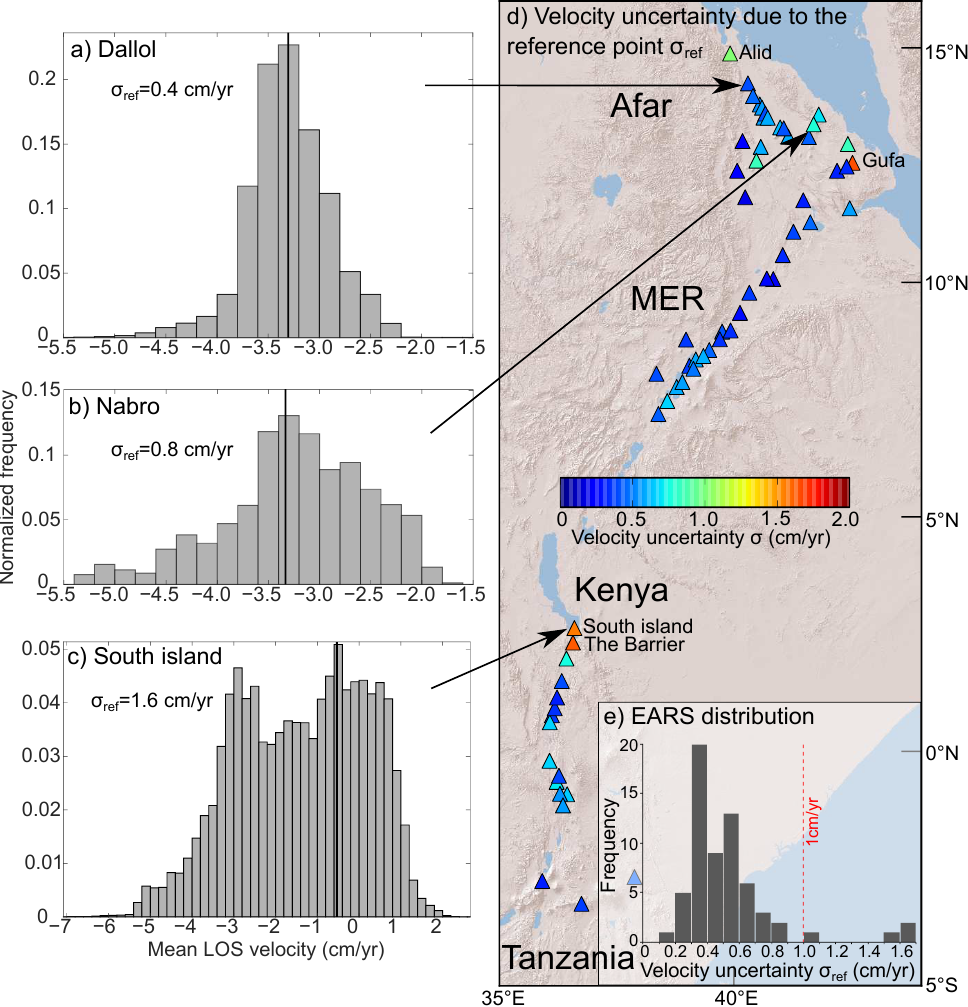
Figure 4. Distribution of the LOS velocity estimates at the centre of the volcanoes ( a ) Dallol, ( b ) Nabro and ( c ) South island, using all the pixels outside the volcanoes as a potential reference point. Vertical black lines indicate the peak of frequency. The standard deviation of the distribution (1 σ ) is an indication of the velocity uncertainty due to the choice of the reference point, ( d ) map showing the LOS velocity uncertainty for all the volcanoes processed, ( e ) distribution of the uncertainty along the